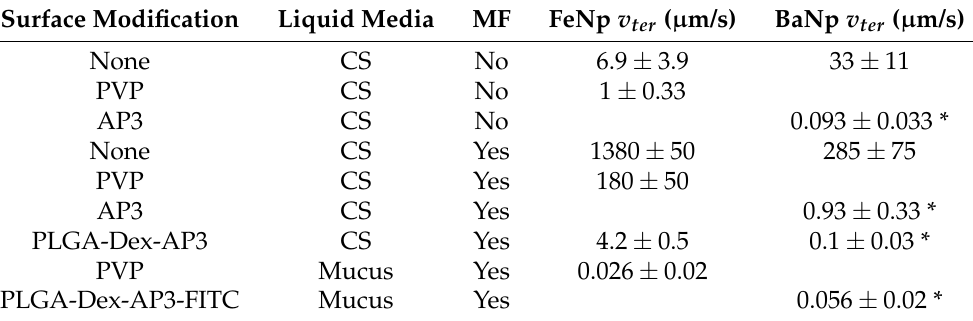
Table 6. Terminal velocity, v ter of different MNP types and surface modifications, in mucus or corn syrup (CS), with gravity only or with gravity and MF. Terminal velocities are constant under gravity, whereas under a spatial varying MF, v ter s depended on the position z above the magnet. For corn syrup, v ter was recorded at 5000 µ m above the magnetic tip, while, for mucus, it was recorded at 2450 µ m above the magnetic tip. Terminal velocity v ter was calculated from r m , r n , and M sat with values and errors listed in Tables 1 and 5, by Equations (8), (11), and (12). Uncertainty in v ter was then propagated from errors in r m , r n , and M sat by the method of Section 2.8. We note that v ter could also be determined by the graphical approach in Section